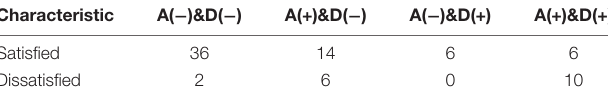
TABLE 5 | The number of patients who were satisfied or dissatisfied with the surgical results after 6 months.